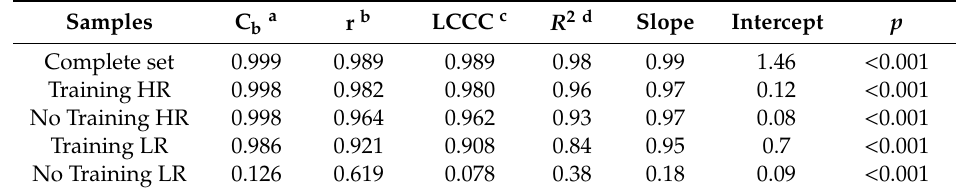
Table 1. Agreement and reliability parameters of the comparison of infection frequency measured visually or with the RUST script under different conditions. Bias correction factor or generalized bias (Cb), Pearson (r), and Lin’s concordance correlation coefficient (LCCC), regression statistics, and model parameters for linear regression were calculated with SPSS software. The full dataset was obtained from n = 892 samples. The effect of training on high-resolution (HR) or low-resolution (LR) images was estimated from a set of n = 30 samples.